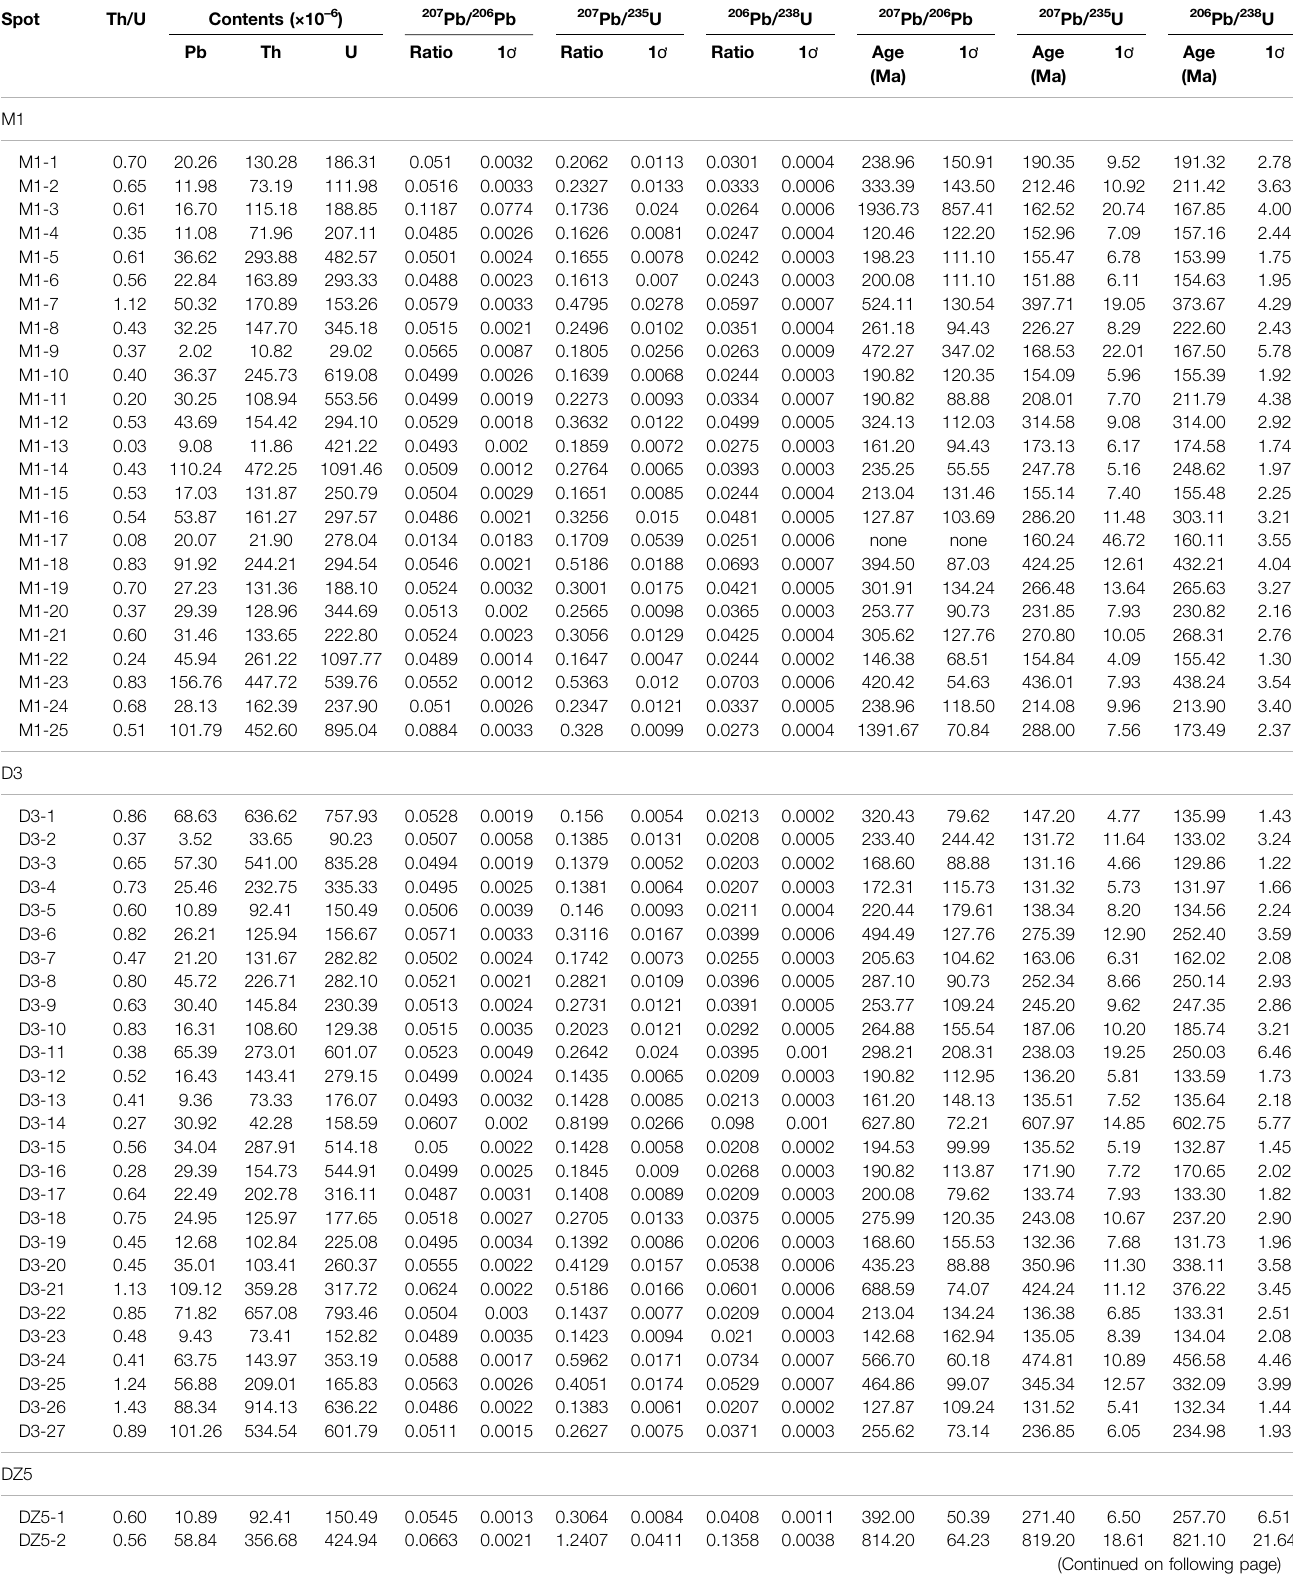
TABLE 2 | LA – ICP – MS U – Pb isotopic data for zircons from the lamprophyres in the Tuquan